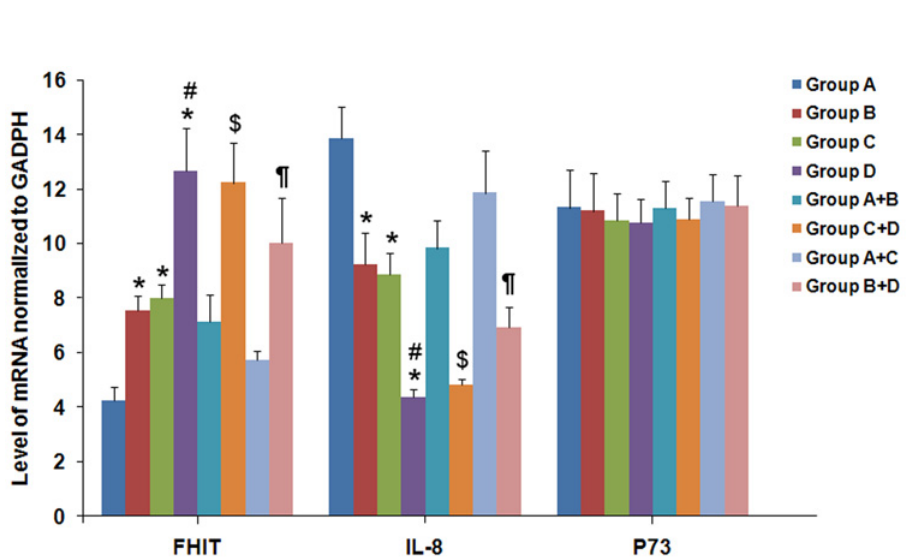
Fig 3. Effect of H . pylori infection and family histories of gastric cancer on mRNA expression of FHIT, IL-8 and P73 before eradication of H . pylori . Group A: patients with both H . pylori infection and family histories of gastric cancer. Group B: patients with H . pylori infection and without family histories of gastric cancer. Group C: patients without H . pylori infection and with family histories of gastric cancer. Group D: patients without both H . pylori infection and family histories of gastric cancer. Data were expressed as the mean ± standard deviation. Statistical differences were determined by Kruskal-Wallis rank test. Compared with Group A, * P < 0.01; compared with Group B, # P < 0.05; compared with Group A+B, $; compared with Group A+C, ¶ P < 0.05.